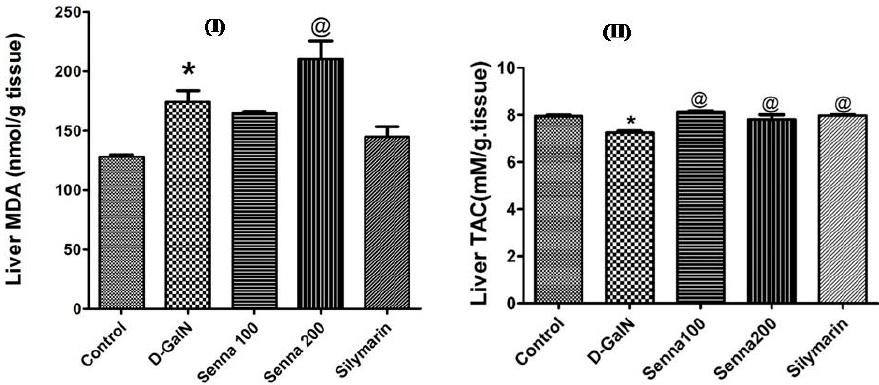
Figure 5. Effect of D-GalN (800 mg/kg, i.p.), bark extract (100 mg/kg and 200 mg/kg, oral), and silymarin on ( I ) MDA (malondialdehyde); ( II ) TAC (total anti-oxidant capacity) (nmol/g tissue) in the liver. Results are presented as mean ± SE. * Significantly different compared to untreated control group, @ Significantly different compared to D -GalN treatment group at p < 0.05. n = 6; using One Way ANOVA followed by Tukey’s post hoc test.